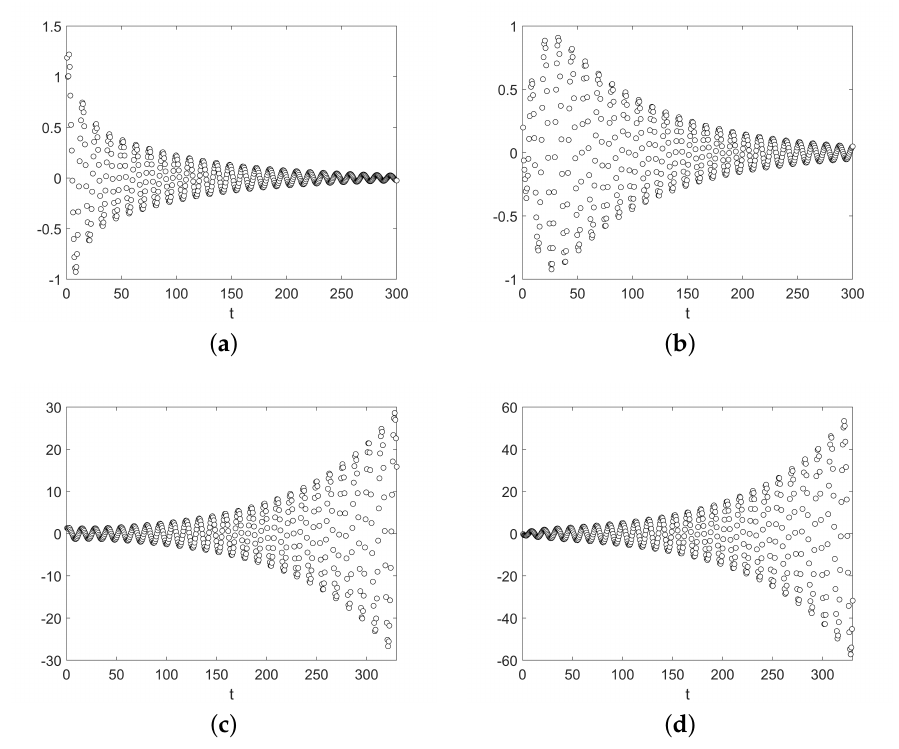
Figure 4. Numerical solutions computed with the method T 2 for Example 2 with two different values of delay, showing stable and unstable behaviours. ( a , b ) First and second component, respectively, with delay τ = 3. ( c , d ) First and second component, respectively, with delay τ =